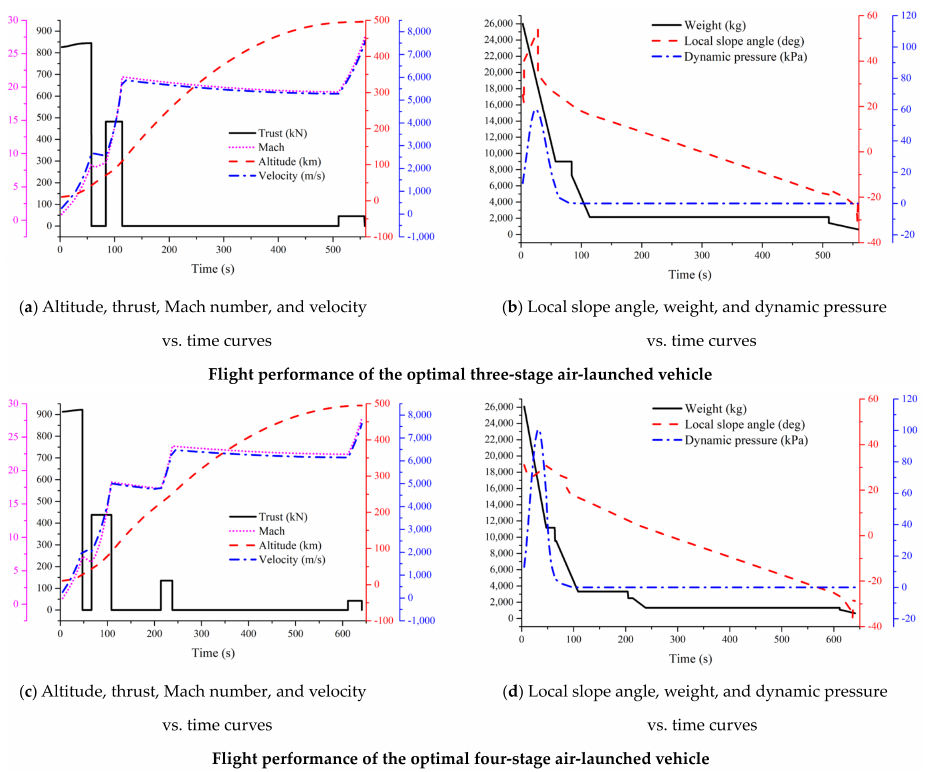
Figure 10. Optimization results of the optimized air-launched